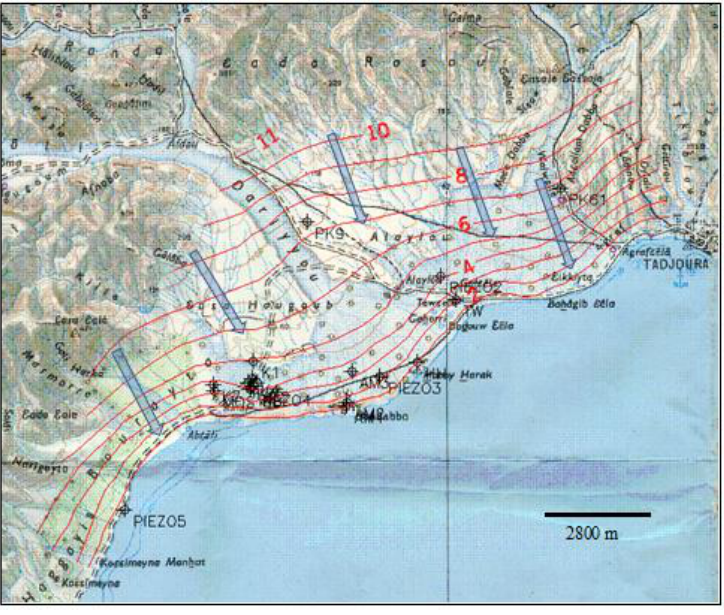
Figure 3. Piezometry of the alluvial coastal aquifer of Tadjourah when wells are not in exploitation.